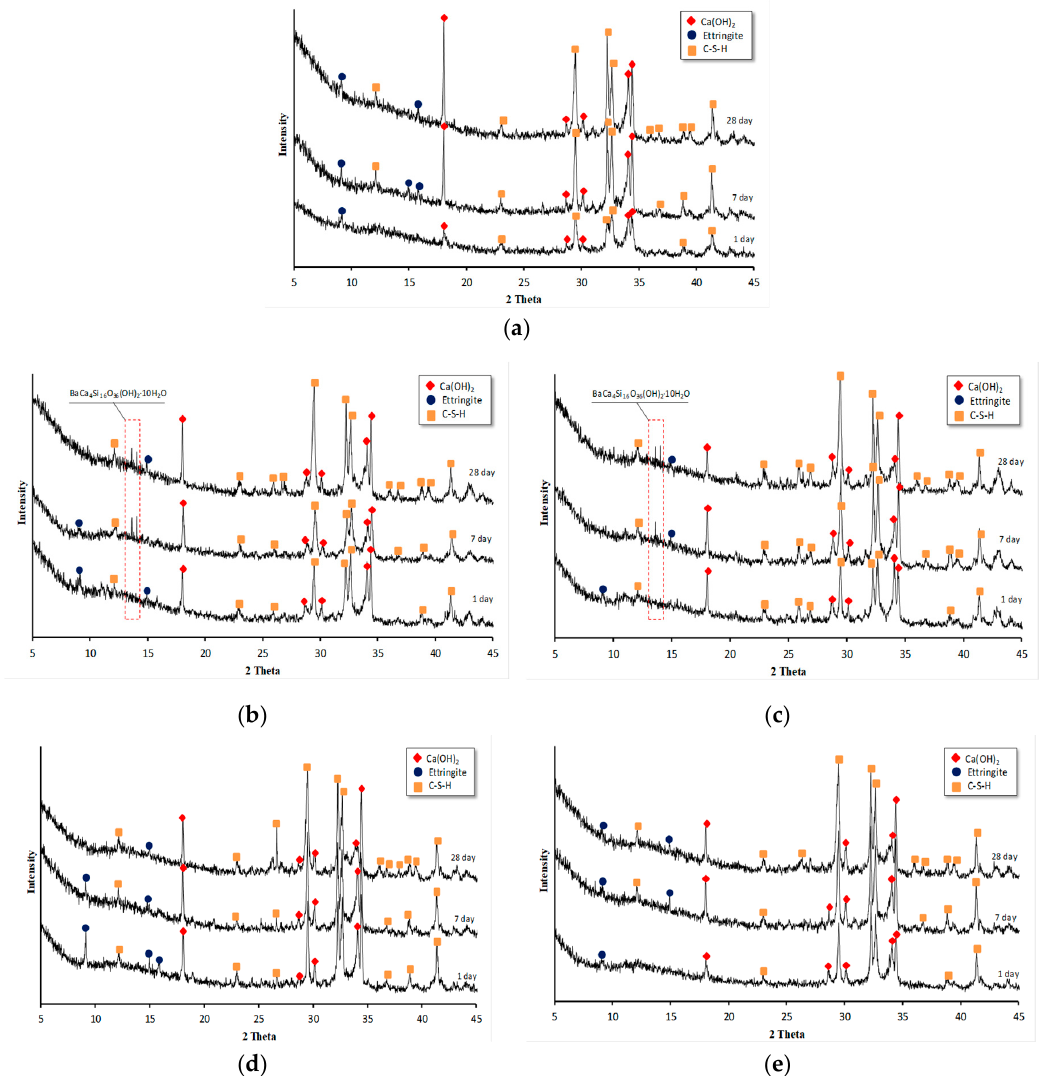
Figure 4. X-ray diffraction analysis results for each specimen for number of days of curing—( a ) cement mortar; ( b ) phase change material with barium (PCM-Ba) (3%) mortar; ( c ) PCM-Ba (5%) mortar; ( d ) phase change material with strontium (PCM-Sr) (3%) mortar; and ( e ) PCM-Sr (5%) mortar.